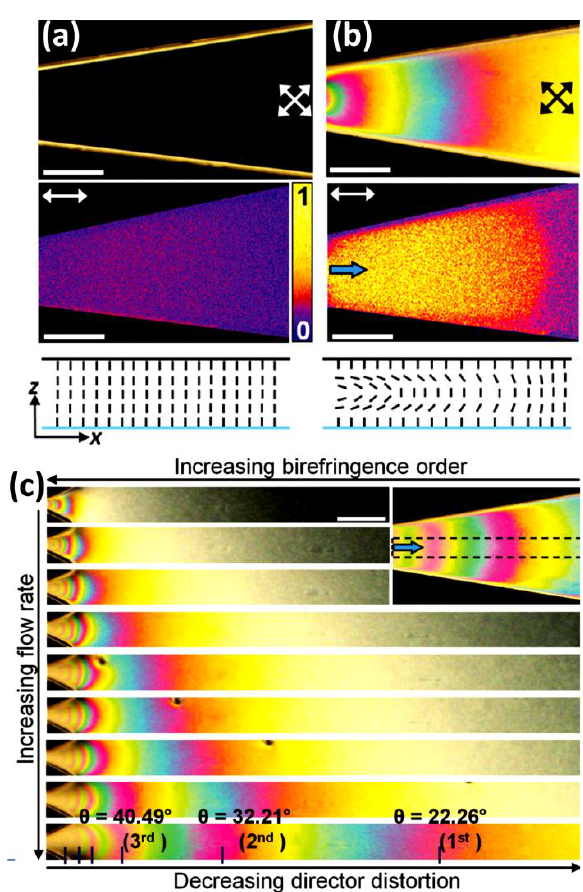
Fig. 1. Optofluidic velocimetry using nematic liquid crystal. (a) Polarized optical micrograph (top row) and fluorescence confocal polarized micrograph (middle row) of a channel filled with 5CB in absence of any flow. (b) At low flow rates, colourful birefringent domains appear, the corresponding fluorescent micrograph revealing the flow-induced director field. The laser is polarized along the flow direction. The bottom row schematically represents the molecular orientation in each case. Scale bar: 300 μm. (c) Polarized micrographs capture the evolution of the birefringent domains with gradual increase of the flow rate, as observed within the region marked in the inset. Adapted from Sengupta et al .